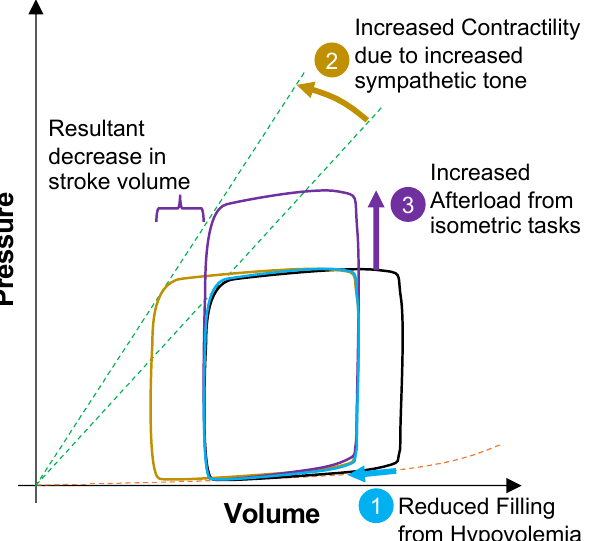
Figure 3. Ventricular function curves showing the sequence of cardiovascular events during hypovolemia while performing an occupational work activity. Hypovolemia causes reduced ventricular filling or preload (1). Then, the body compensates by increased sympathetic tone, resulting in elevated heart rate and cardiac contractility (2). During physical activity, the worker periodically performs upper limb isometric tasks, thus increasing afterload (3). The result is decreased stroke volume and increased myocardial oxygen demands.